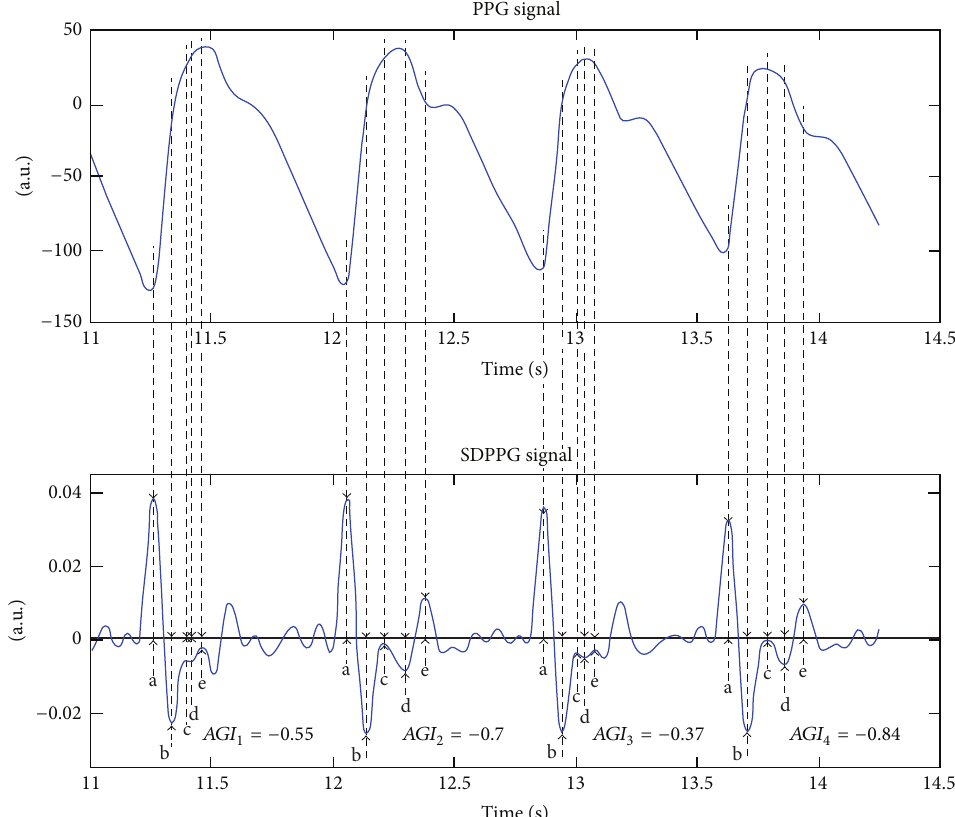
Figure 2: The sample segment of the PPG signal (upper part) from a 37-year-old healthy subject and its second derivative (lower part) with detected wave peaks and AGI values. The SDPPG signal is processed, and the wave amplitudes are detected according to a study by Millasseau et al.